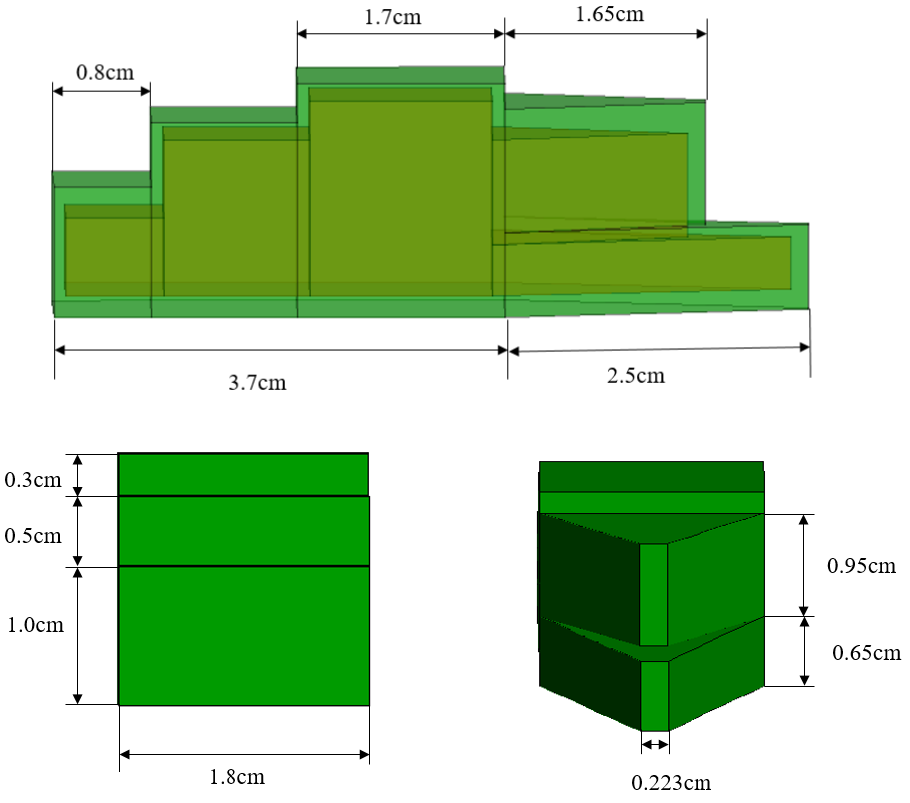
Figure 10. The geometry of the coated boat.